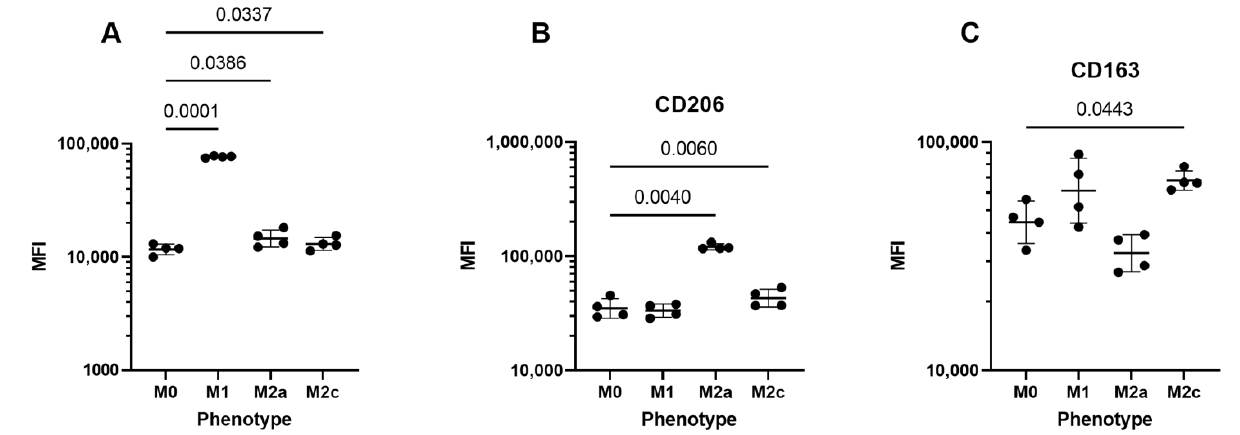
Figure 1. Flow cytometry measures of MDM surface markers. MDMs were polarized into M0, M1, M2a and M2c. Cells were harvested and the surface markers CD80 ( A ), CD206 ( B ) and CD163 ( C ) were measured with flow cytometry. The numbers above the horizontal lines indicate the different p -values.